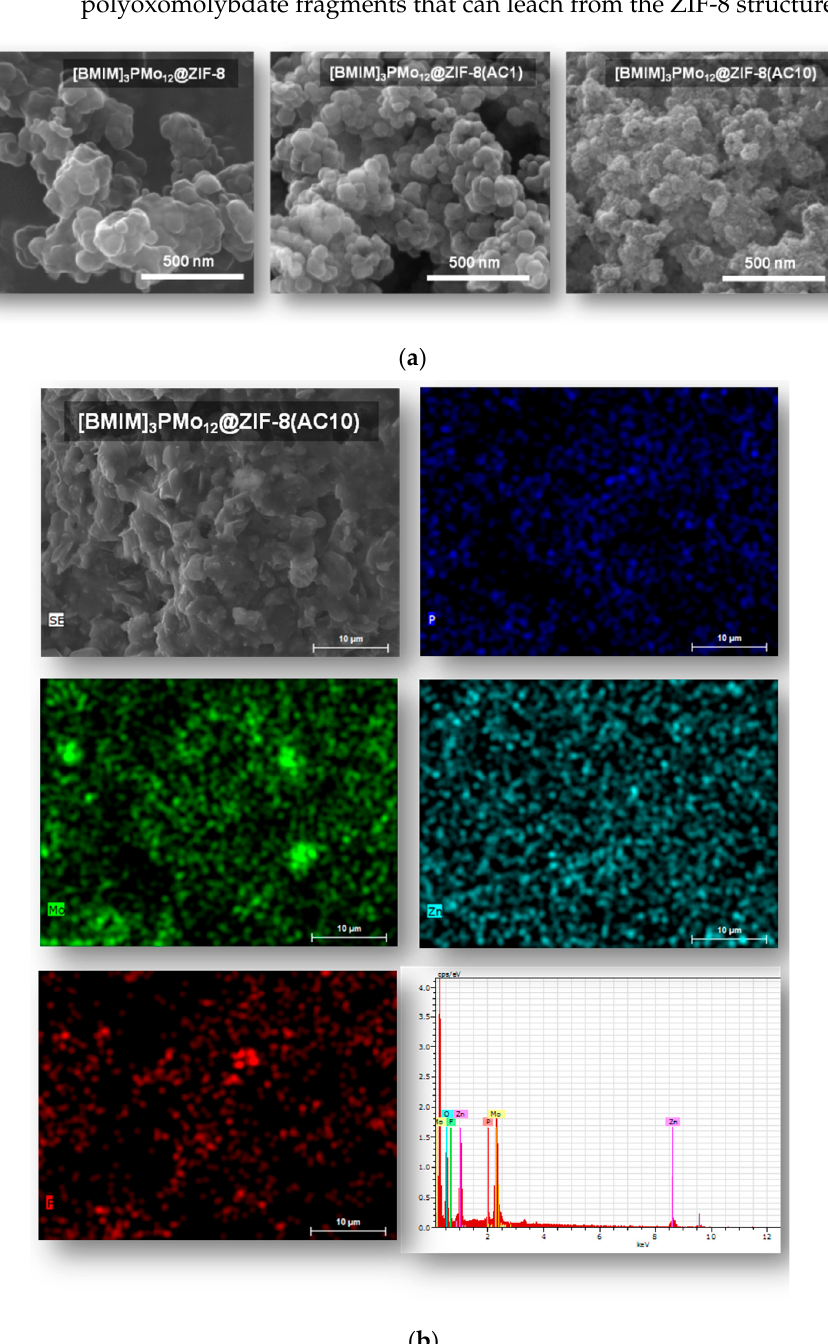
Figure 6. ( a ) SEM micrographs of [BMIM] 3 PMo 12 @ZIF-8 before catalytic utilization, isolated after the